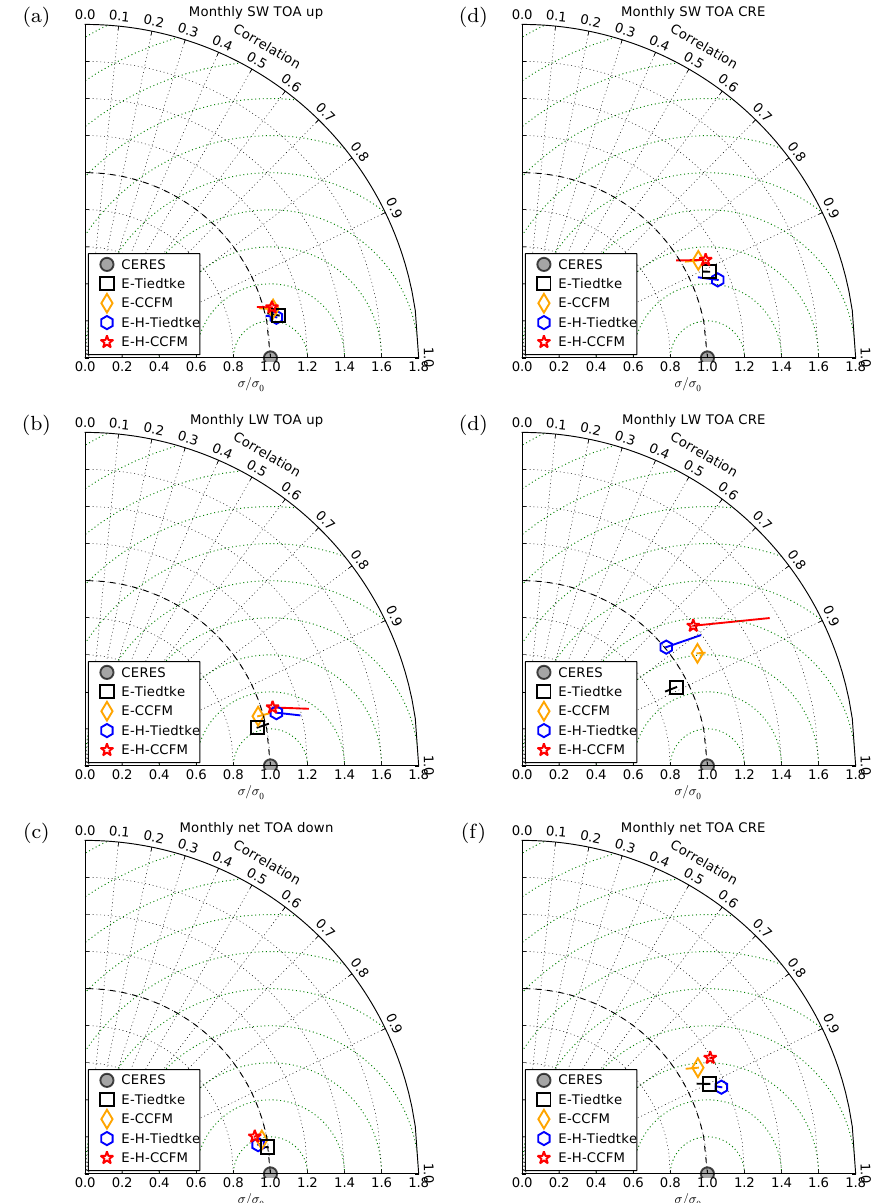
Figure 9. Taylor diagrams comparing monthly mean short-wave (a) , long-wave (b) and net (c) radiative fluxes (left), and corresponding cloud radiative effects ( d–f , right) at the top of the atmosphere between 30-year AMIP-type simulations using ECHAM(–HAM) with Tiedtke– Nordeng and CCFM (L − 2) convection, and a CERES–EBAF climatology. The line segments extending from each point indicate the mean bias, as suggested in Taylor